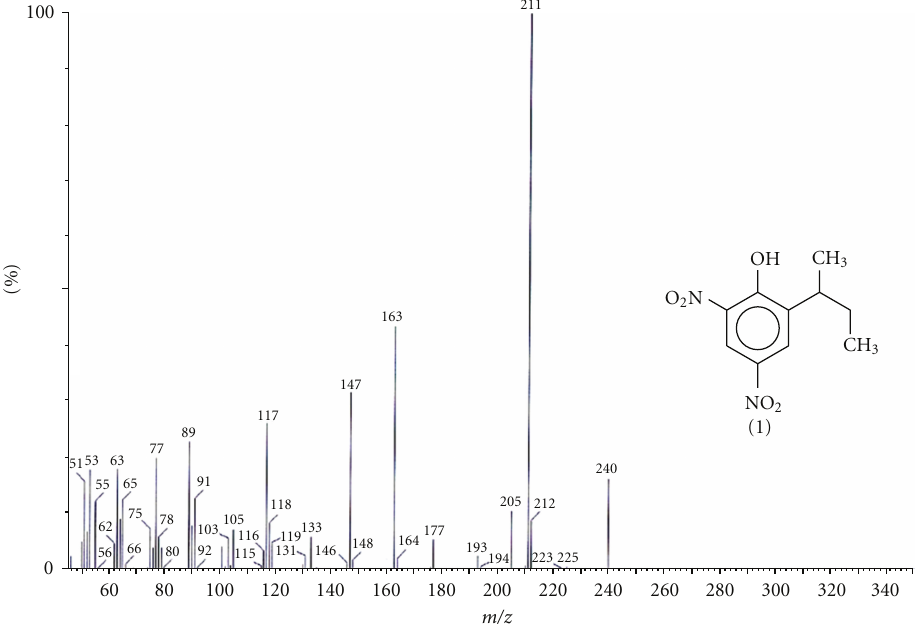
Figure 9: Mass fragmentation pattern of unilluminated Dinoseb appearing at R t 9.76.